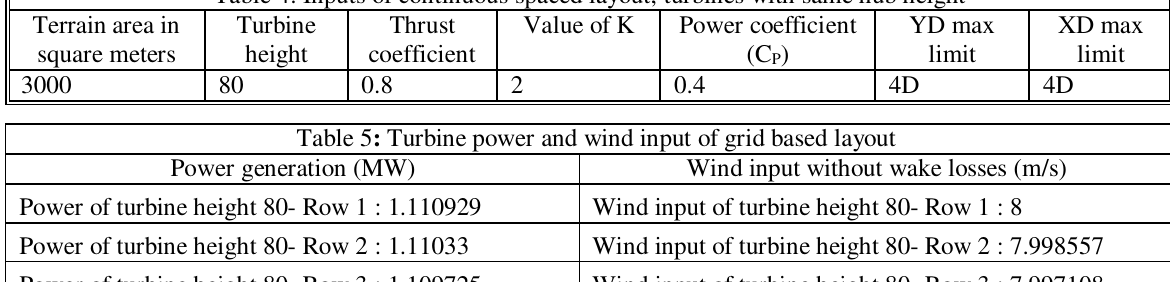
Table 4: Inputs of continuous spaced layout, turbines with same hub height